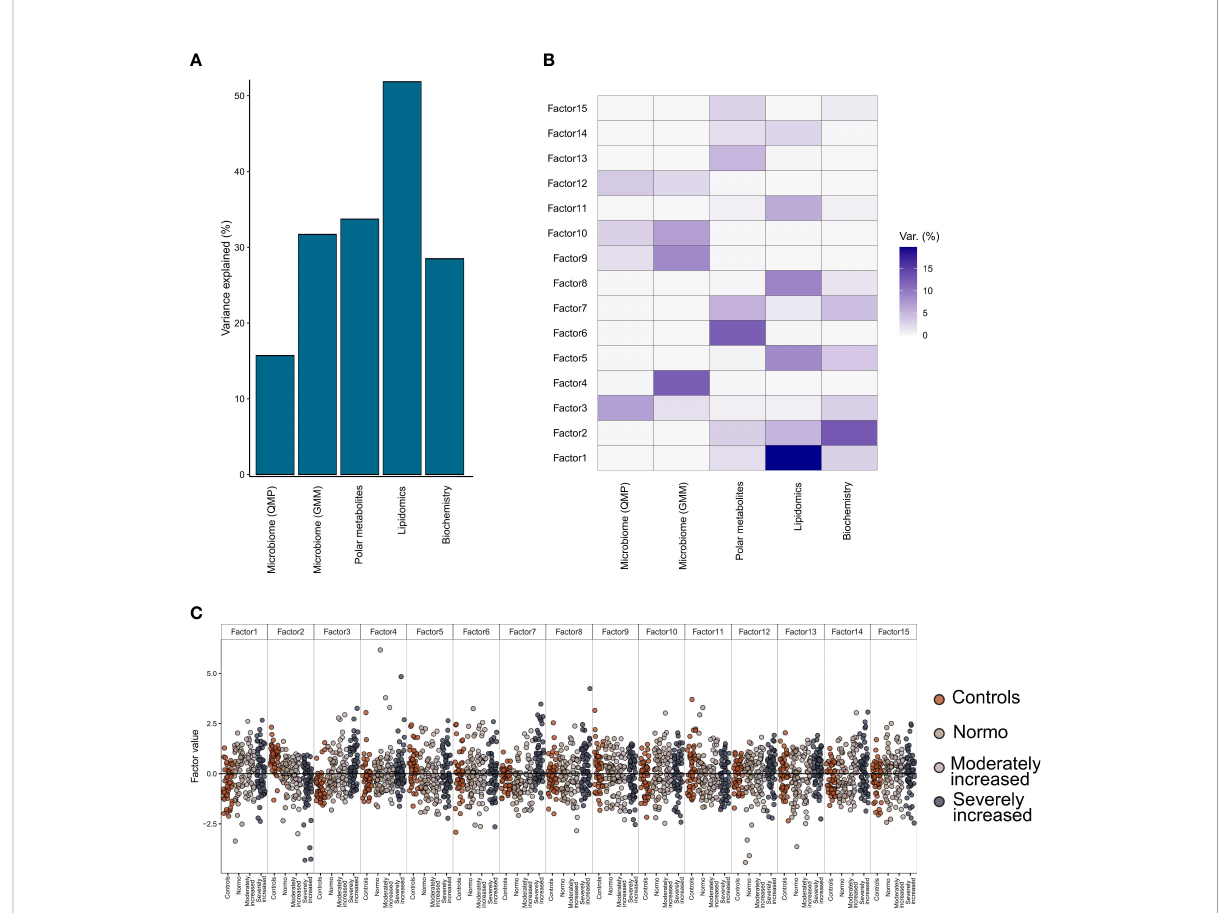
FIGURE 5 Multi-Omics Factor Analysis (MOFA). Results from multi-omics data integration after combining multiple data types: metagenomics data (taxonomical and functional), plasma metabolomics data (polar metabolites and clustered lipids) and biochemistry data using the MOFA+ tool. (A) Global explained variance for each of the data types (included in the integration step) has been represented as a bar chart. (B) Composition of 15 individual factors generated with the proportion of explained variance by each of the data types, displayed as a white-to-blue gradient in increasing order. (C) Distribution of the eigenvalues obtained for each of the factors for the combined dataset. Within each of those factors the individual, eigenvalues are represented as dot plots. Different colors in the dot plot depict different clinical study groups: orange for healthy controls, dark gray for T1D with normo-albuminuria, light gray for T1D with moderately increased albuminuria and black for T1D with severely increased albuminuria. Each of the study groups are also labelled in the bottom horizontal